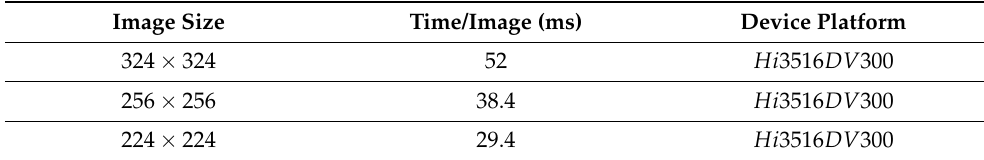
Table 8. Computation Time for Different Image Sizes.